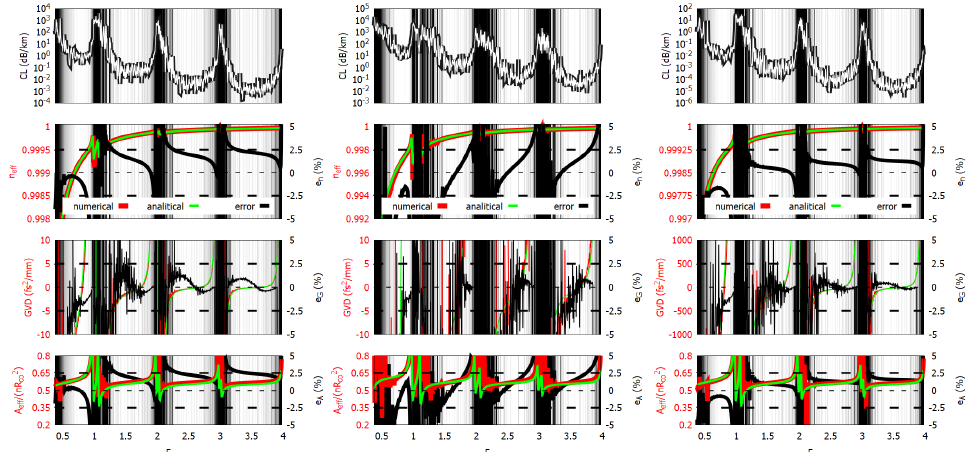
Figure 12. Confinement loss ( top row ), effective index ( top-central row ), group velocity dispersion ( bottom-central row ), and effective area ( bottom row ) of KF#1 ( left ), KF#2 ( center ), and KF#3 ( right ). In IC#1, the core boundary is very similar to a TLF with δ = 0. For this kind of fiber as well, the analytical formulas show good agreement and small error values with respect to the numerical results. The rapid oscillations in the e G curve are due to the residual coupling with cladding modes, which is a feature of these fibers. The same effect is observed in KFs. Despite the different core shape, the agreement between numerical results and analytical ones (obtained considering the equivalent TLF) is just